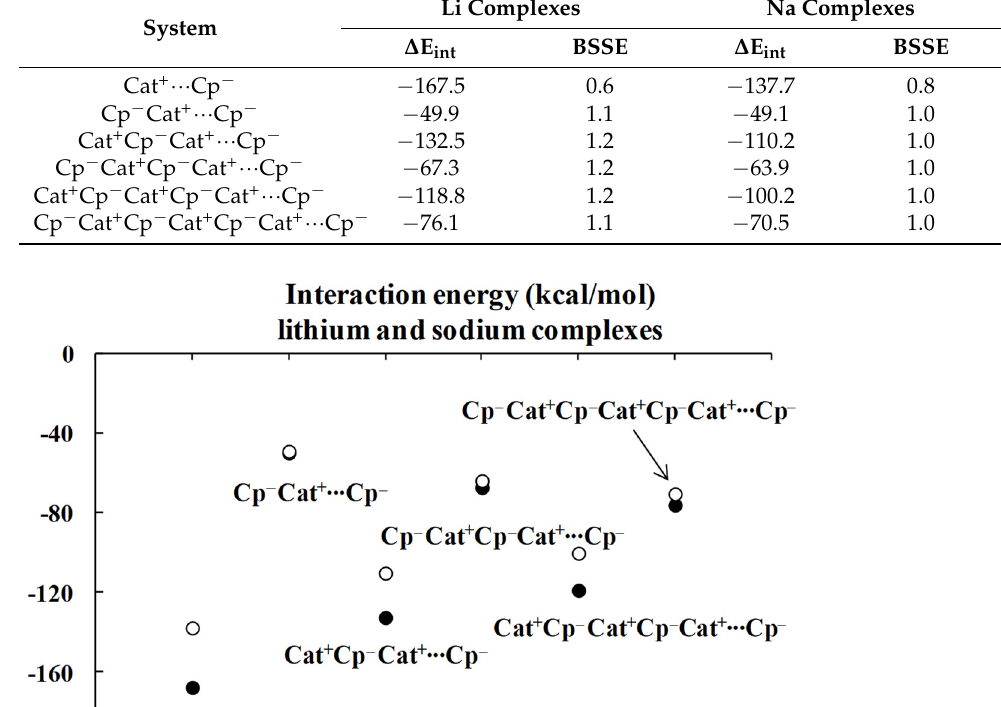
Table 2. The interaction energies calculated at the ω B97XD/6-311++G(d,p) level (in kcal/mol) for the lithium and sodium complexes; BSSE corrections are included (kcal/mol). Li Complexes System